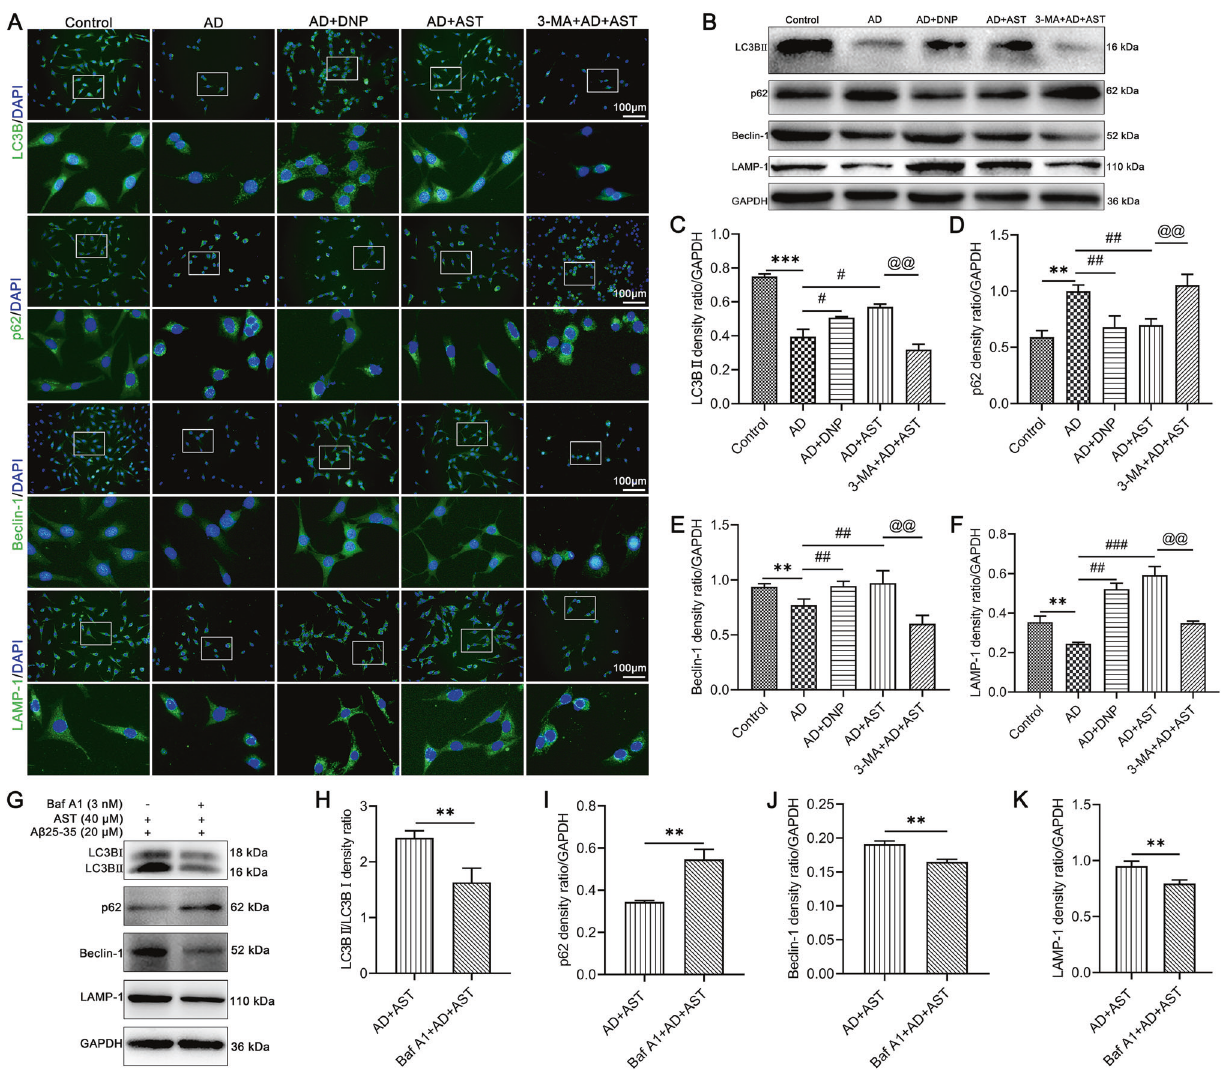
Fig. 7 The expressions of LC3BII/LC3BI, p62, Beclin-1, and LAMP-1 in HT22 cells were detected by Immuno fl uorescent staining and WB detection. A Observation of LC3B, p62, Beclin-1, and LAMP-1 expression in HT22 cells by immuno fl uorescent staining, Scale bar = 100 μ m. B Representative bands of LC3BII/LC3BI, p62, Beclin-1, and LAMP-1 in HT22 cells by WB detection. C – F Statistical analysis of the corresponding LC3BII/LC3BI, p62, Beclin-1, and LAMP-1 protein bands. Data were presented as mean ± SD, n = 3/group. ** p < 0.01 vs control group, ## p < 0.01 and ### p < 0.001 vs AD group, @@ p < 0.01 and @@@ p < 0.001 vs. AST + AD group. G Representative bands of LC3BII/LC3BI, p62, Beclin-1, and LAMP-1 were detected by WB after the administration of Baf A1 in AD cell model. H – K Statistical analysis of the corresponding LC3BII/LC3BI, p62, Beclin-1, and LAMP-1 protein bands. Data were presented as mean ± SD, n = 3/group. ** p < 0.01 vs AST + AD